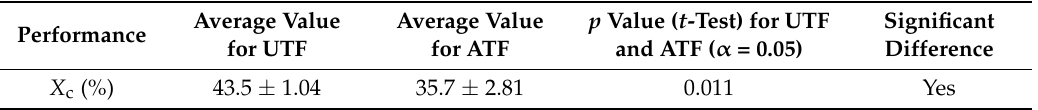
Table 3. Crystallinity degree of BFs.